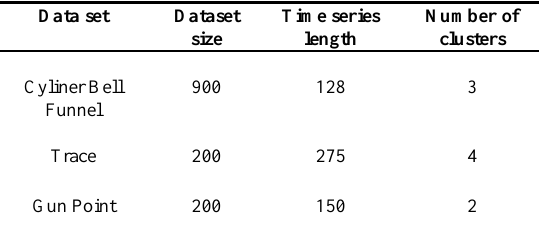
Table 3. The properties of